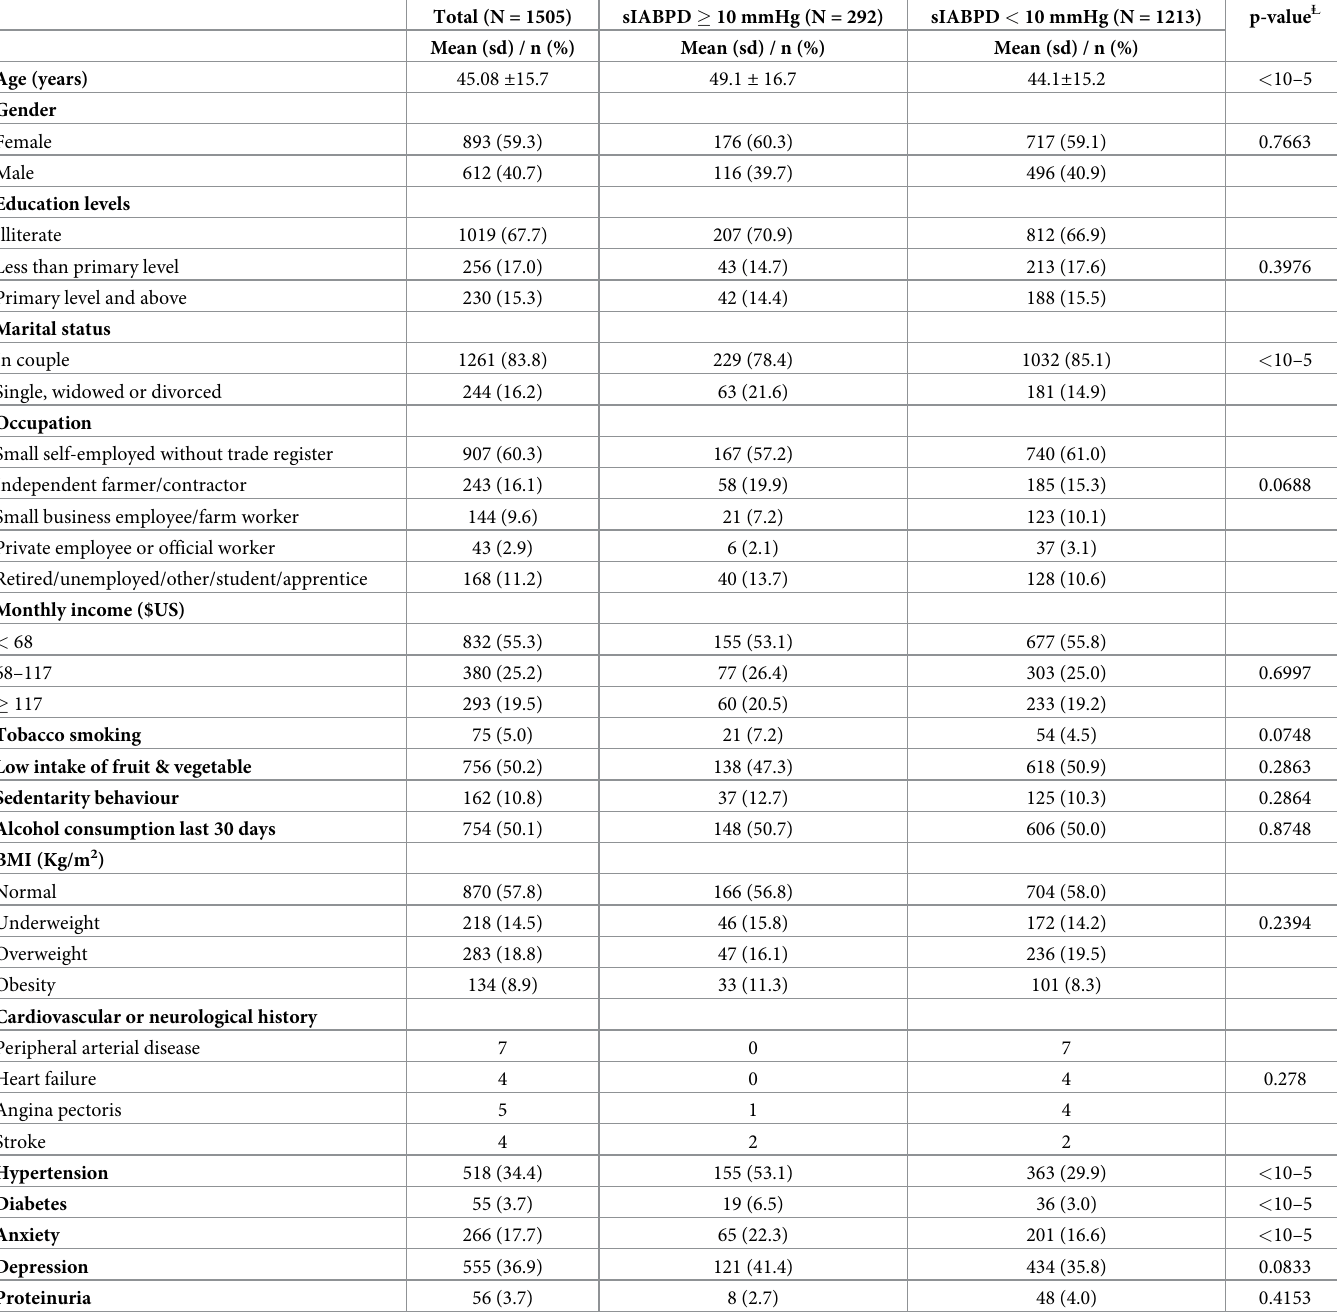
Table 1. Systolic inter arm blood pressure difference groups according to socio-demographic characteristics, behavioural characteristics, anxiety, depression and proteinuria, TAHES study, Benin